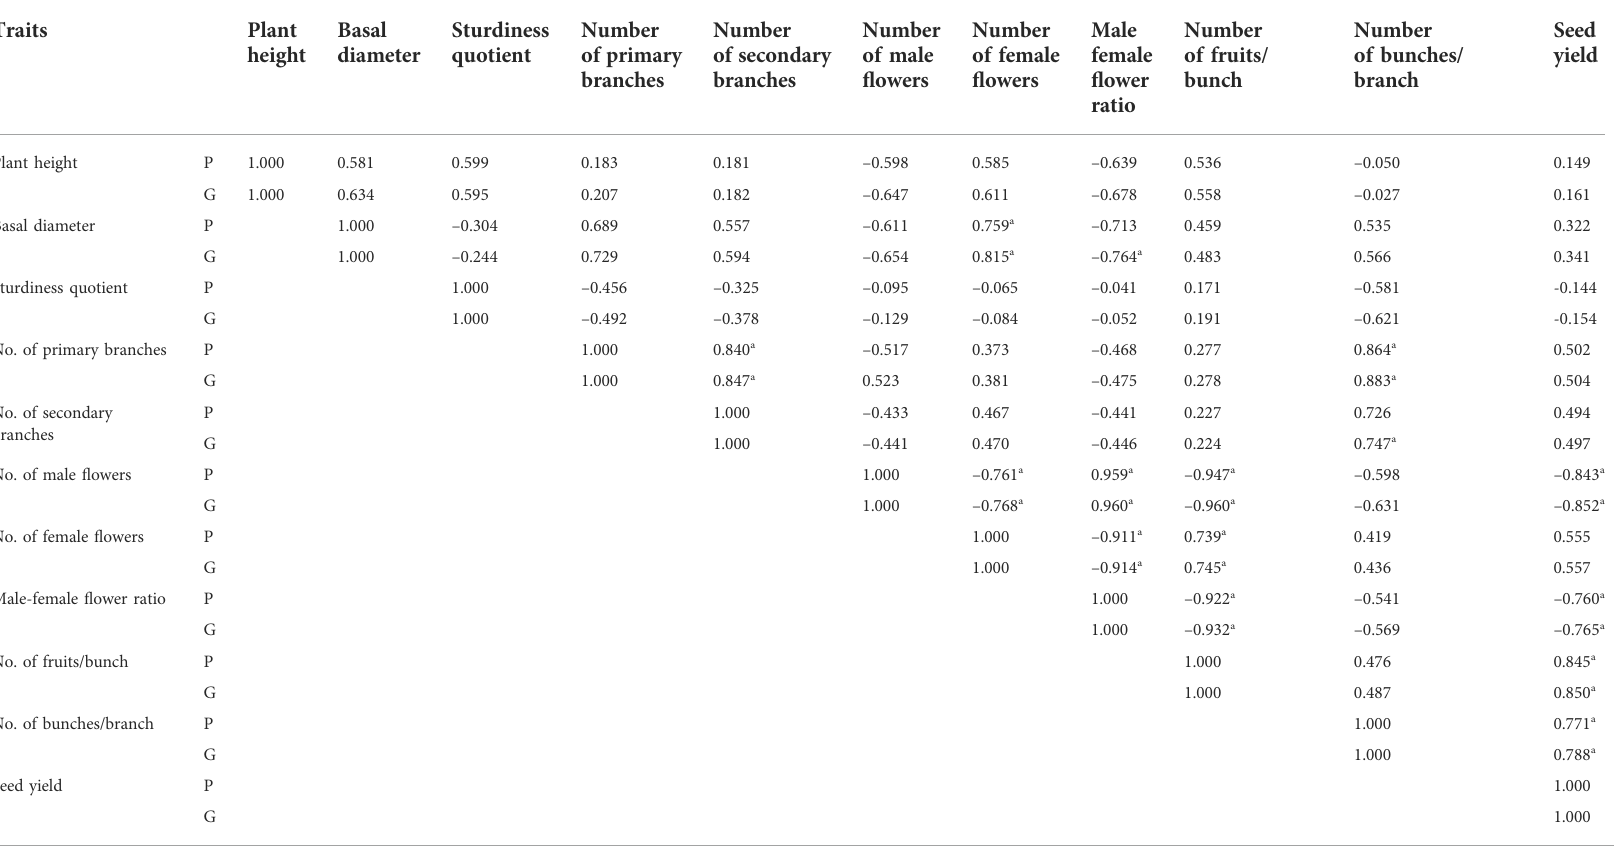
TABLE 4 Phenotypic and genotypic correlation coef fi cients among biometrical traits on seed yield.